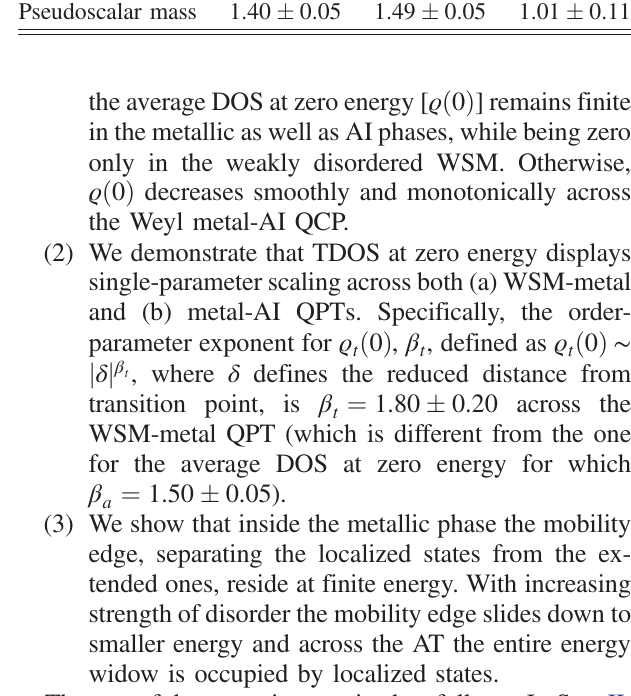
transition (AT), but only in the presence of random charge impurities. Our central achievements regarding the fate of the AT in strongly disordered Weyl metal are the following.